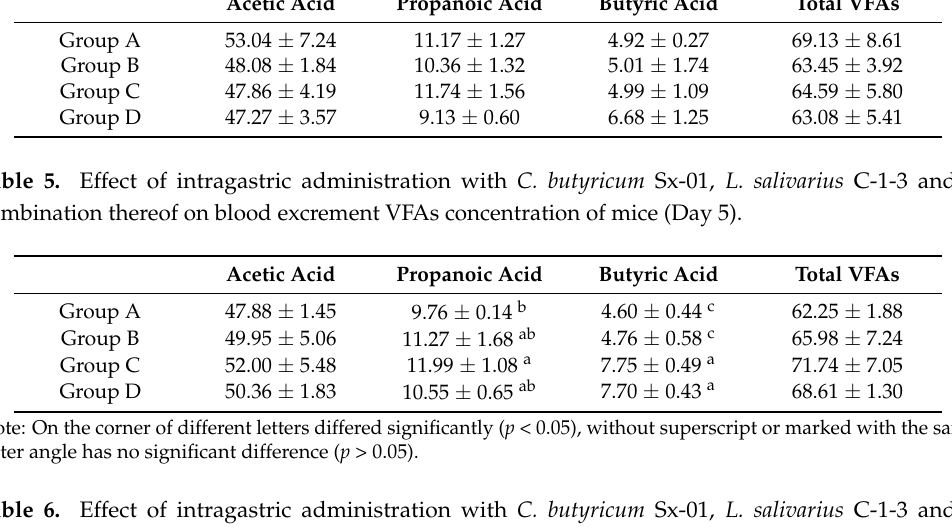
Table 6. Effect of intragastric administration with C. butyricum Sx-01, L. salivarius C-1-3 and a combination thereof on blood excrement VFAs concentration of mice (Day